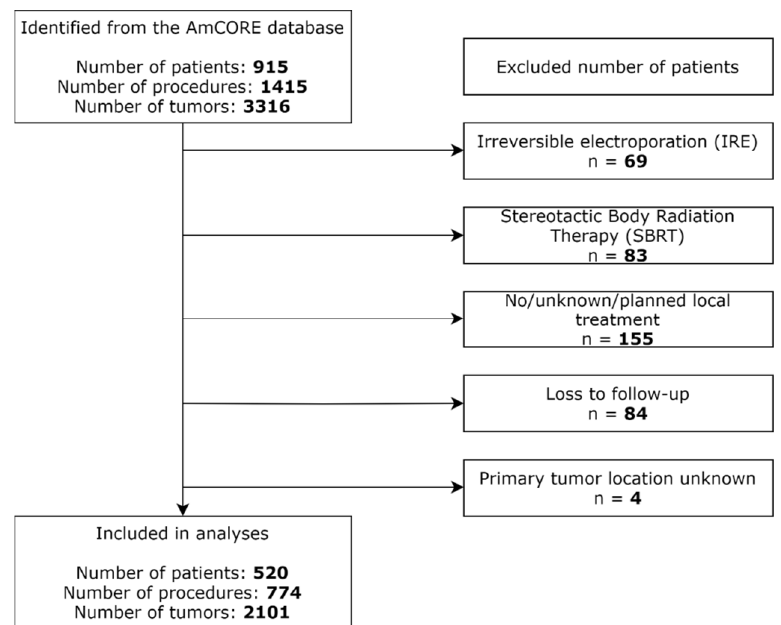
Figure 1. Flowchart of included and excluded patients. Table 1. Patient-, procedure-, and tumor-related